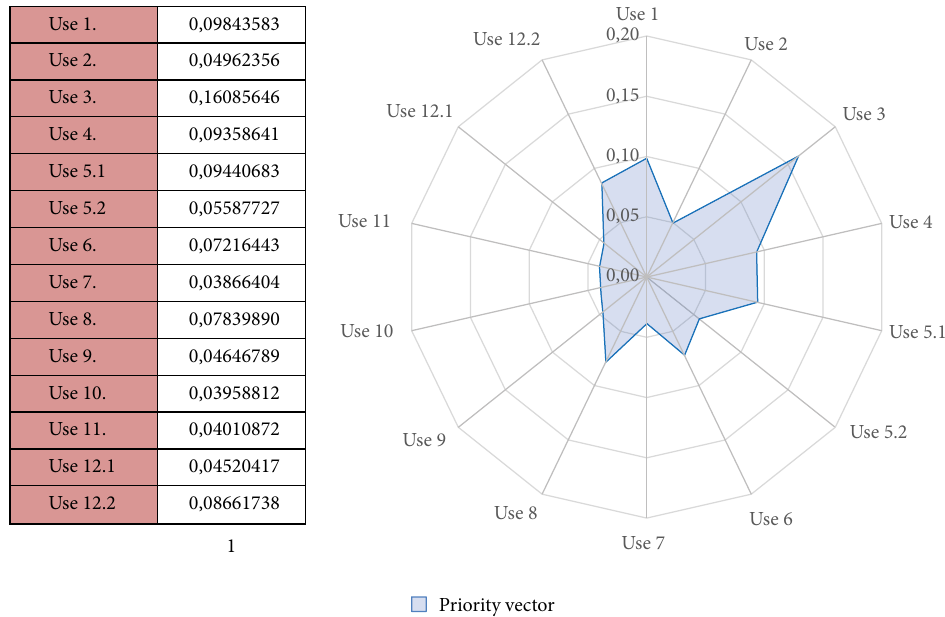
Figure 5: Priority vector for the uses considered and their distribution shown in a spider chart.